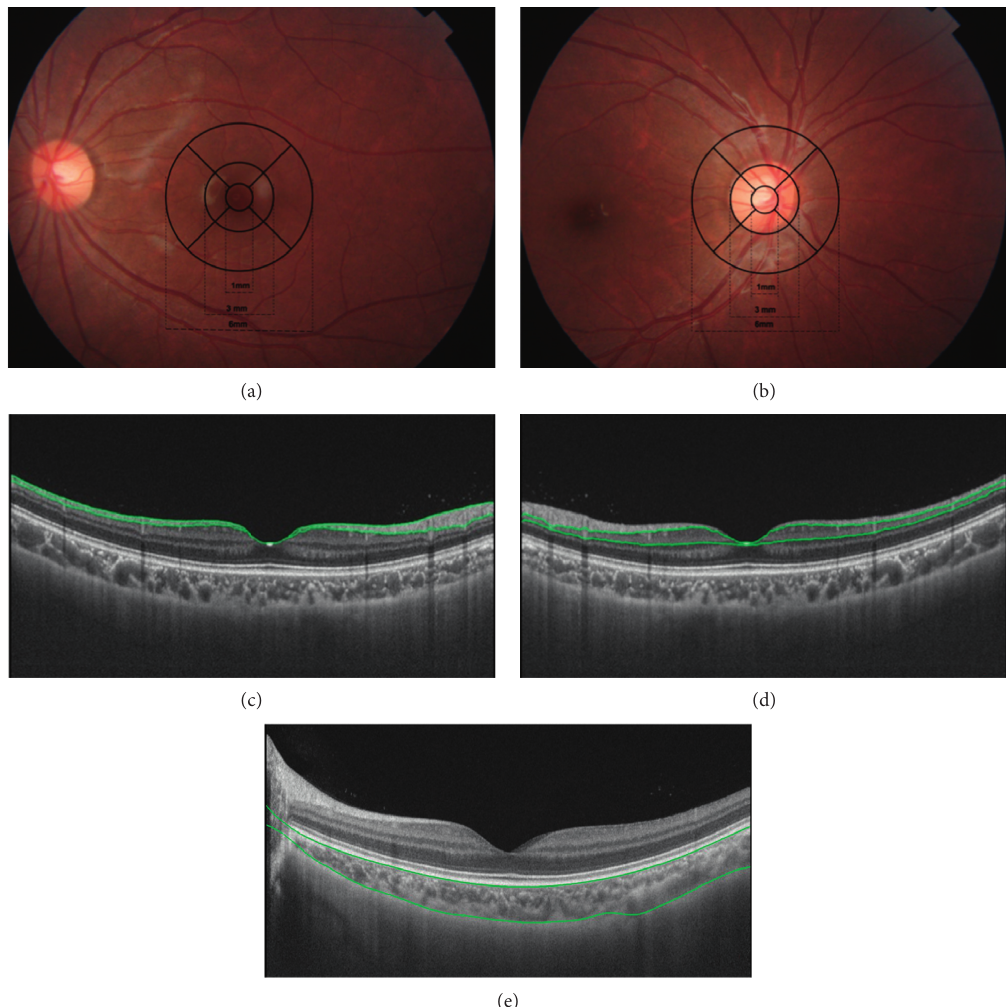
Figure 1: Optical coherence tomography schematic diagram. (a) The Early Treatment Diabetic Retinopathy Study (ETDRS) grid: central circle (diameter � 1mm), macular inner circle (diameter � 3mm), and macular outer circle (diameter � 6mm). (b) ETDRS grid: central circle (diameter � 1mm), optic disc inner circle (diameter � 3mm), and optic disc outer circle (diameter � 6 mm). (c) RNFL thickness (the interface between the nerve fiber layer and ganglion cell layer to the inner limiting membrane). (d) GCL thickness (the interface between the nerve fiber layer and ganglion cell layer to the interface between the inner plexiform layer and inner core layer). (e) Choroidal thickness (Bruch’s membrane to the choroid-sclera